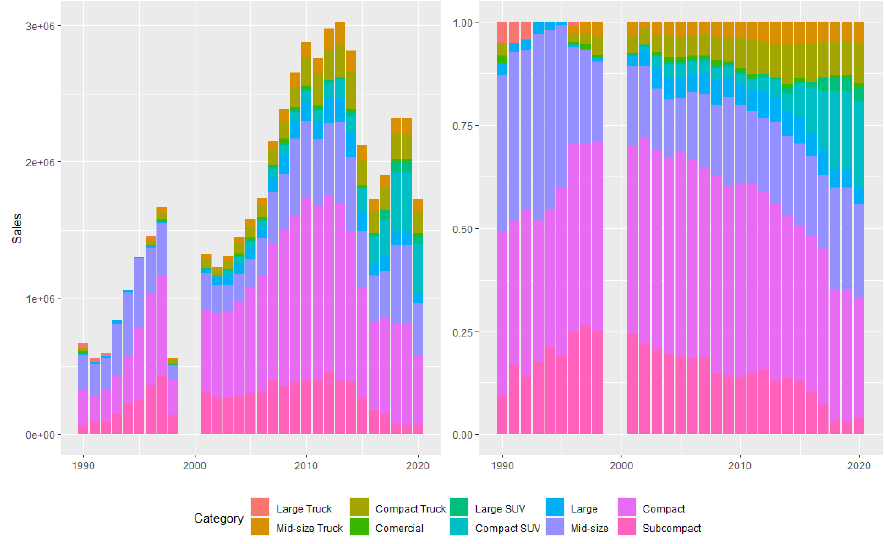
Figure 7. Vehicle registration categories from 1990 to 2020 (horizontal